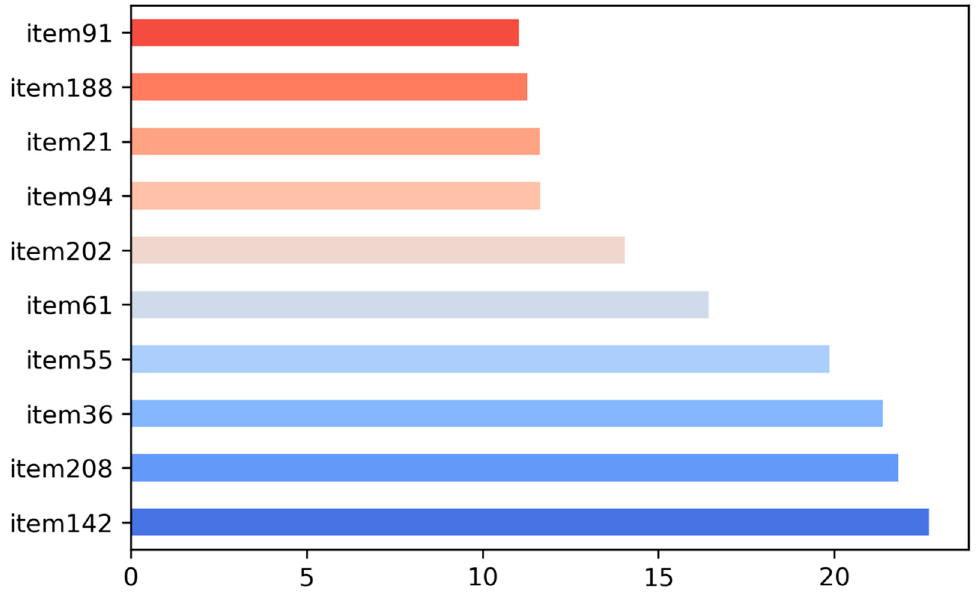
Figure 1. Top ten measurement items sorted by feature scores.